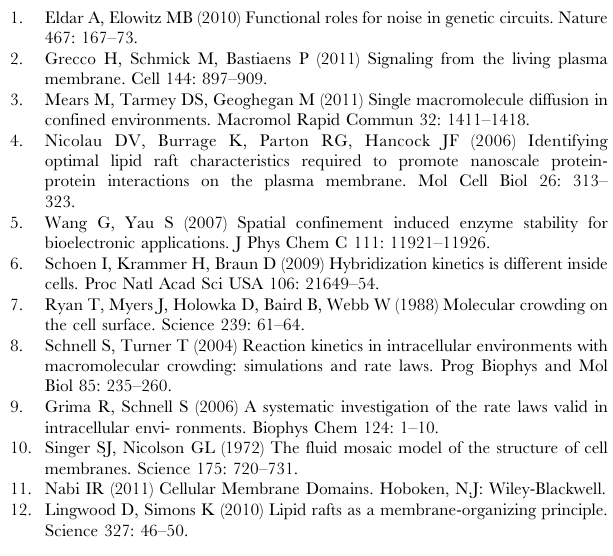
Figure S1 Illustration of the Master equation picture of diffusion with periodically placed barriers. Figure S2 Behavior of R m and R s (described in the text) as a function of t dim . Data obtained by Monte Carlo simulations. Parameters values are P cross ~ 9 | 10 { 4 , N ~ 200 , L ~ 20 a , r ~ 0 : 1 . Error bars were obtained by subsampling the data by bootstrapping and indicate 95% confidence intervals. Figure S3 Total number of reactions involving the tracer molecule as a function of time. Results are obtained by Monte Carlo simulations (ensemble averaged over 1000 non- overlapping segments of the simulation data). All definitions and parameter values are the same as those of Figure 1(a) of the main text. For visual clarity, each data set is plotted with a different offset along the x-axis. Figure S4 Distribution of the time between reactions for different confinement strengths. A. All parameter values are the same as in Fig. 3(a) of the main text. A bin size of 100 simulation steps was used to calculate the probabilities. The numbers in the legend correspond to the value of P cross . B. distribution of the time between reactions for P cross ~ 2 : 5 | 10 {